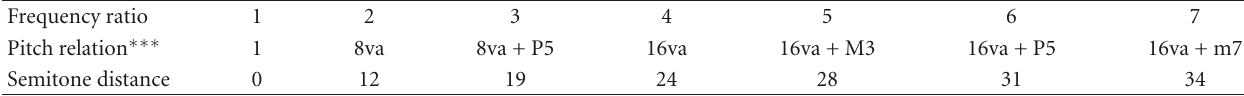
Table 2: Frequency and pitch relations of seven harmonics.